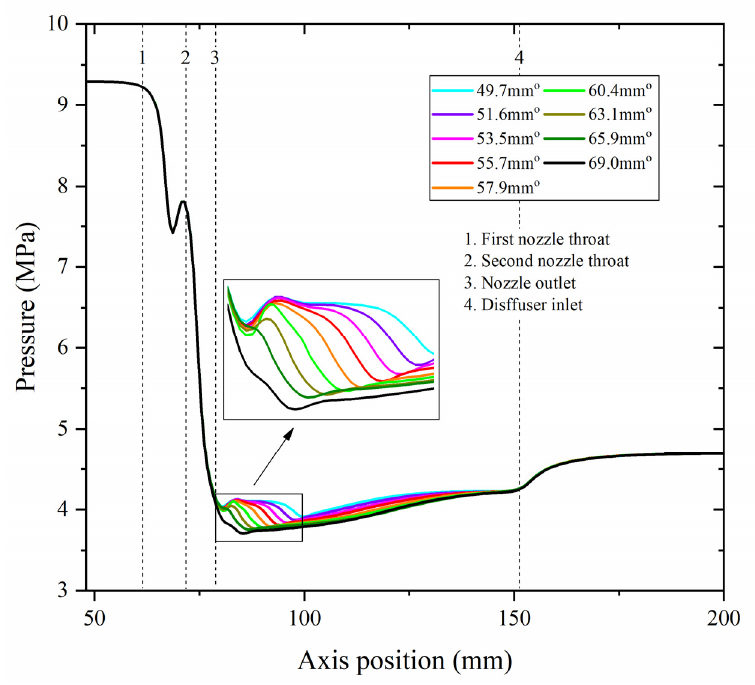
Figure 14. Variations of axial static pressure under different θ pm ( P p of 9.3 MPa).